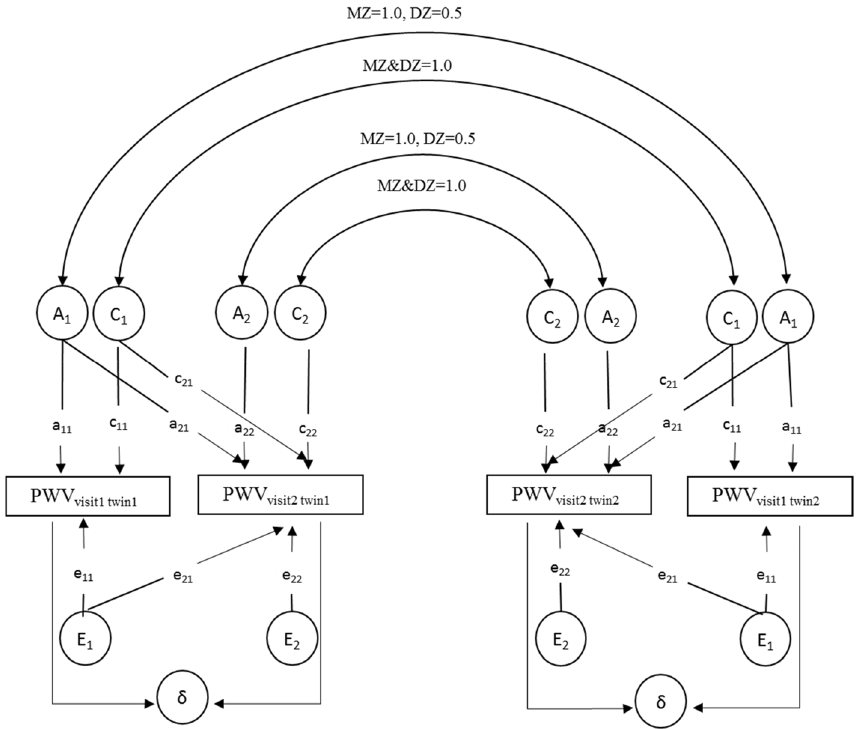
Figure 1. Bivariate structural equation model. The A 1 and A 2 are additive genetic factors. The E 1 and E 2 are unique environment factors. The C 1 and C 2 are shared environment factors. The paths of genetic factors are a 11 through a 22 . The paths of unique environment factor are e 11 through e 22 . The paths of shared environment factor are c 11 through c 22 . Subtracting the level of measured PWV at visit 2 from visit 1 is established by setting the path coefficients of δ originating from visit 1 and visit 2 to − 1 to 1, respectively.